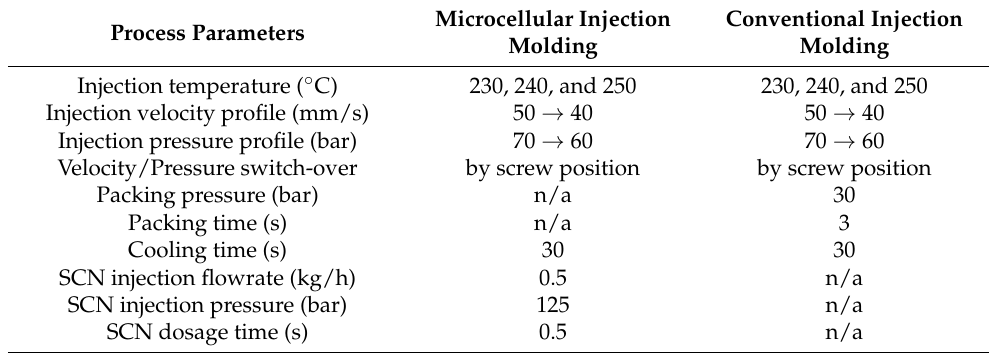
Table 2. Process parameters of the injection molding